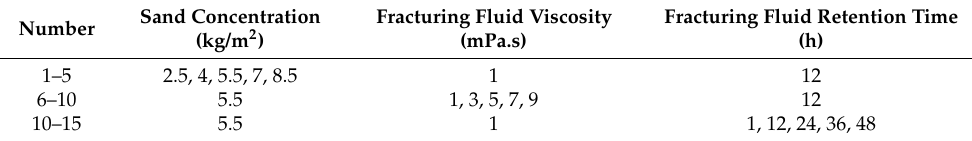
Table 1. Design of the single factor test for the proppant conductivity damage.